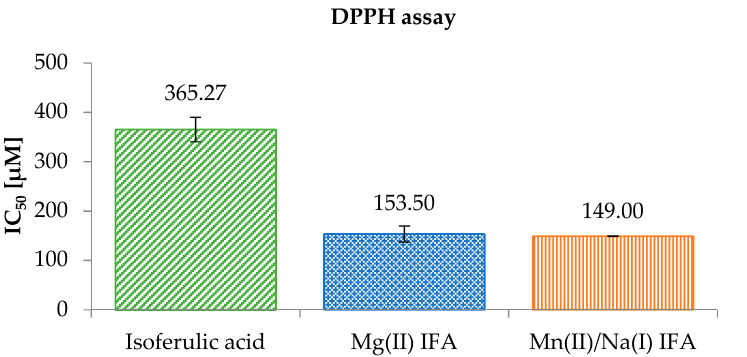
Figure 5. A comparison of the antioxidant activities of the tested compounds (methanolic solutions) measured by DPPH • assay.